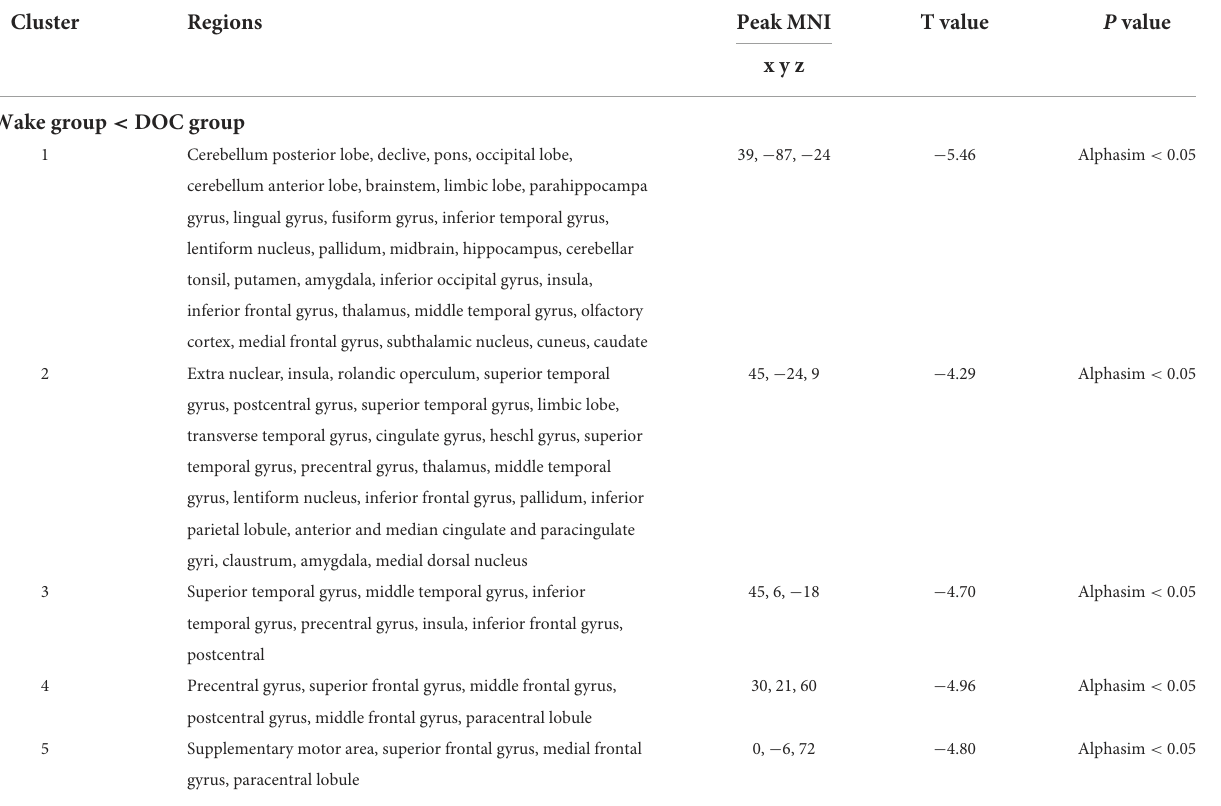
TABLE 3 Decreased functional connectivity (thalamus to whole-brain) in wake